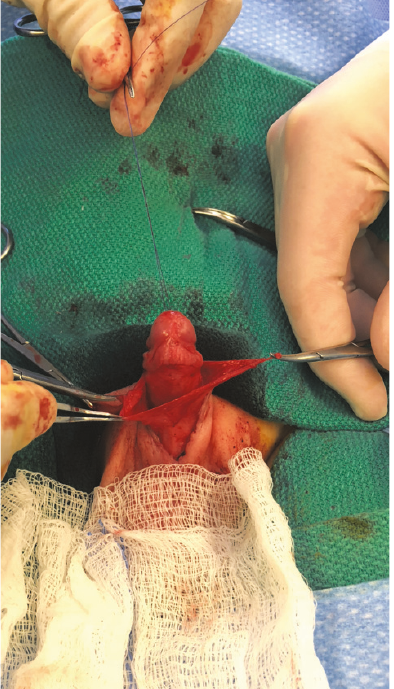
Figure 2: Isolated dysplastic dartos muscle prior to